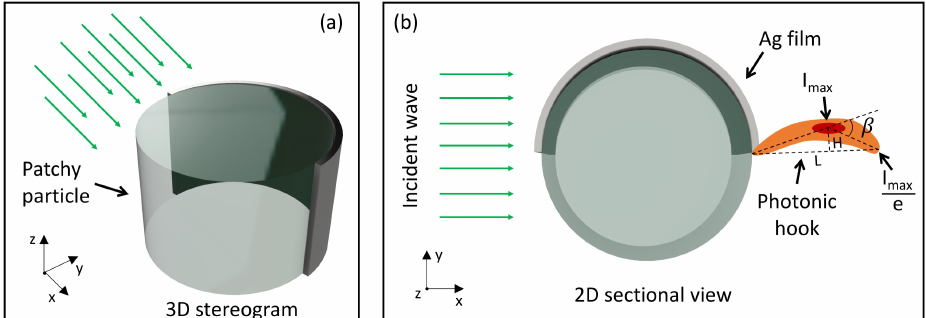
Figure 1. Schematics of a patchy microcylinder illuminated by plane waves: ( a ) 3D stereogram and ( b ) 2D sectional view.